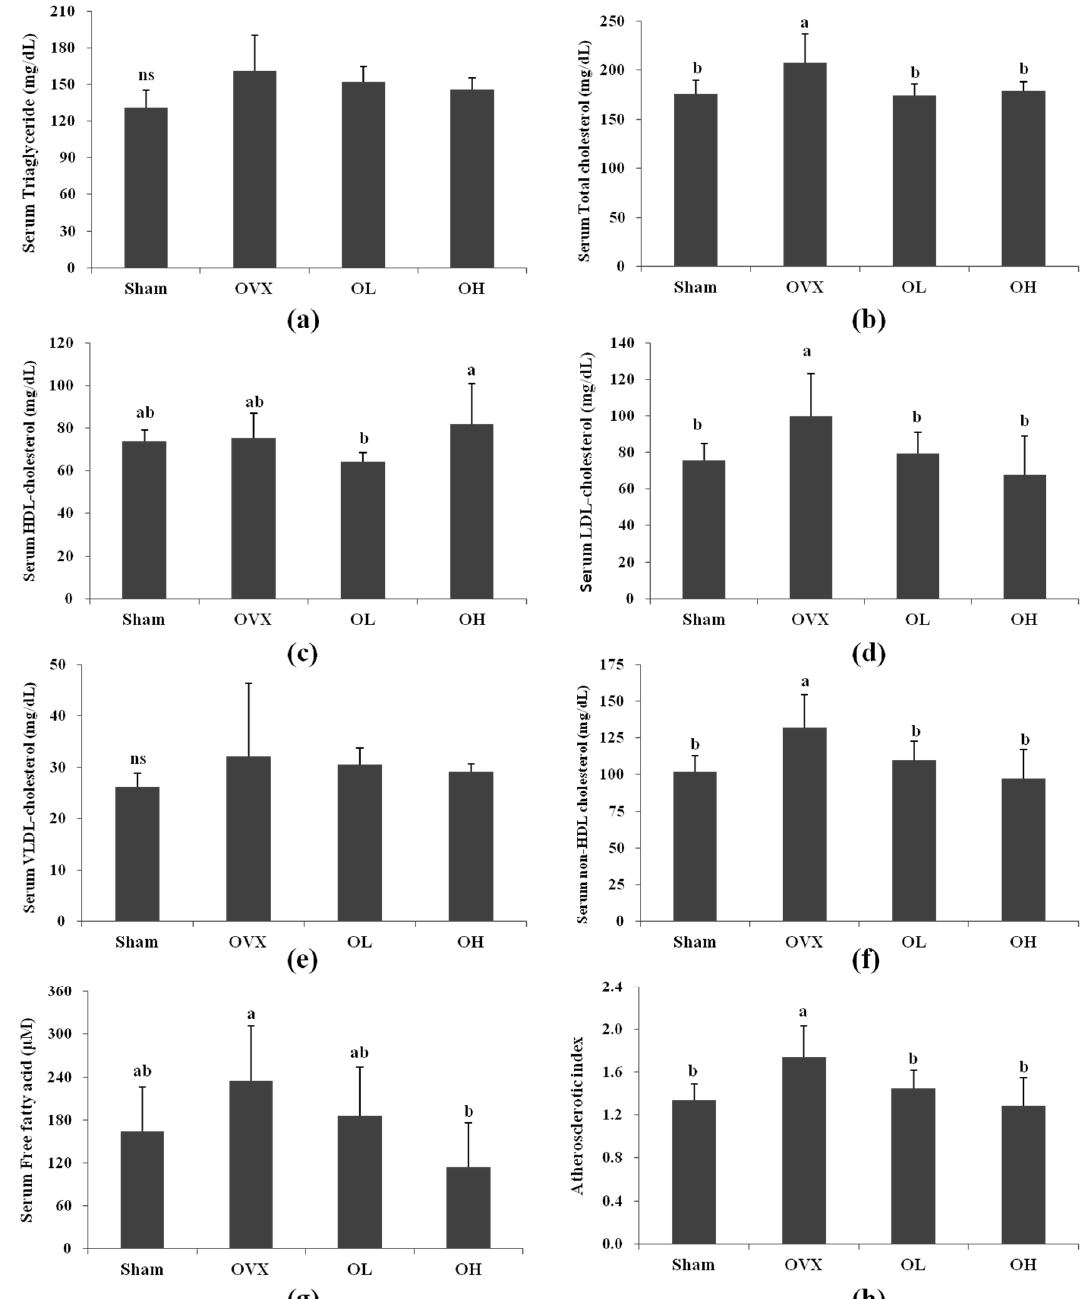
Figure 3. Blood biochemical variables of each group. ( a ) Serum triglyceride; ( b ) Serum total cholesterol; ( c ) Serum HDL cholesterol; ( d ) Serum LDL cholesterol; ( e ) Serum VLDL cholesterol; ( f ) Serum non ‐ HDL cholesterol; ( g ) Serum free fatty acid; ( h ) Atherosclerotic index. ns, not significant; Values are mean ± SD ( n = 7 for each group). The different letters (a > b > c) within a column indicate significant differences ( p < 0.05) determined by Duncan’s multiple range test; Sham, the non ‐ OVX control; OVX, the OVX ‐ control; OL, the OVX + 100 mg/kg b.w. of hawthorn extract; OH, the OVX + 200 mg/kg b.w. of hawthorn extract;